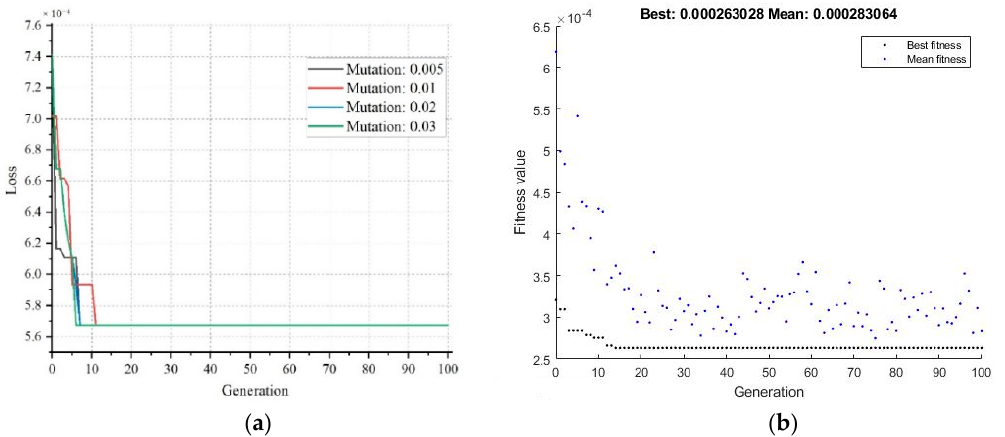
Table 5. The genetic algorithm parameters settings for feature selection.